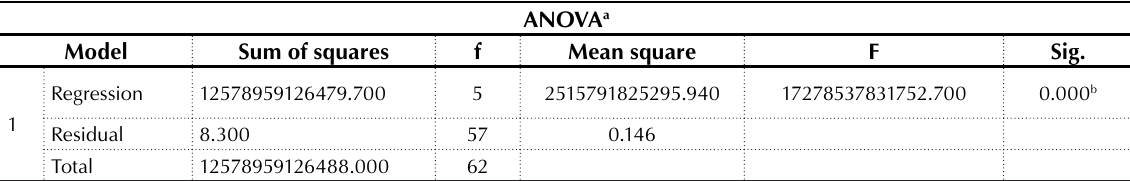
Table 5. ANOVA test for overall significance